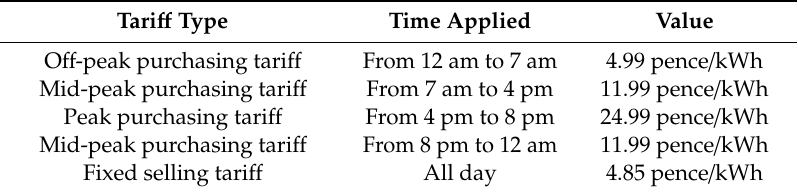
Table 4. Purchasing and selling electricity tari ff